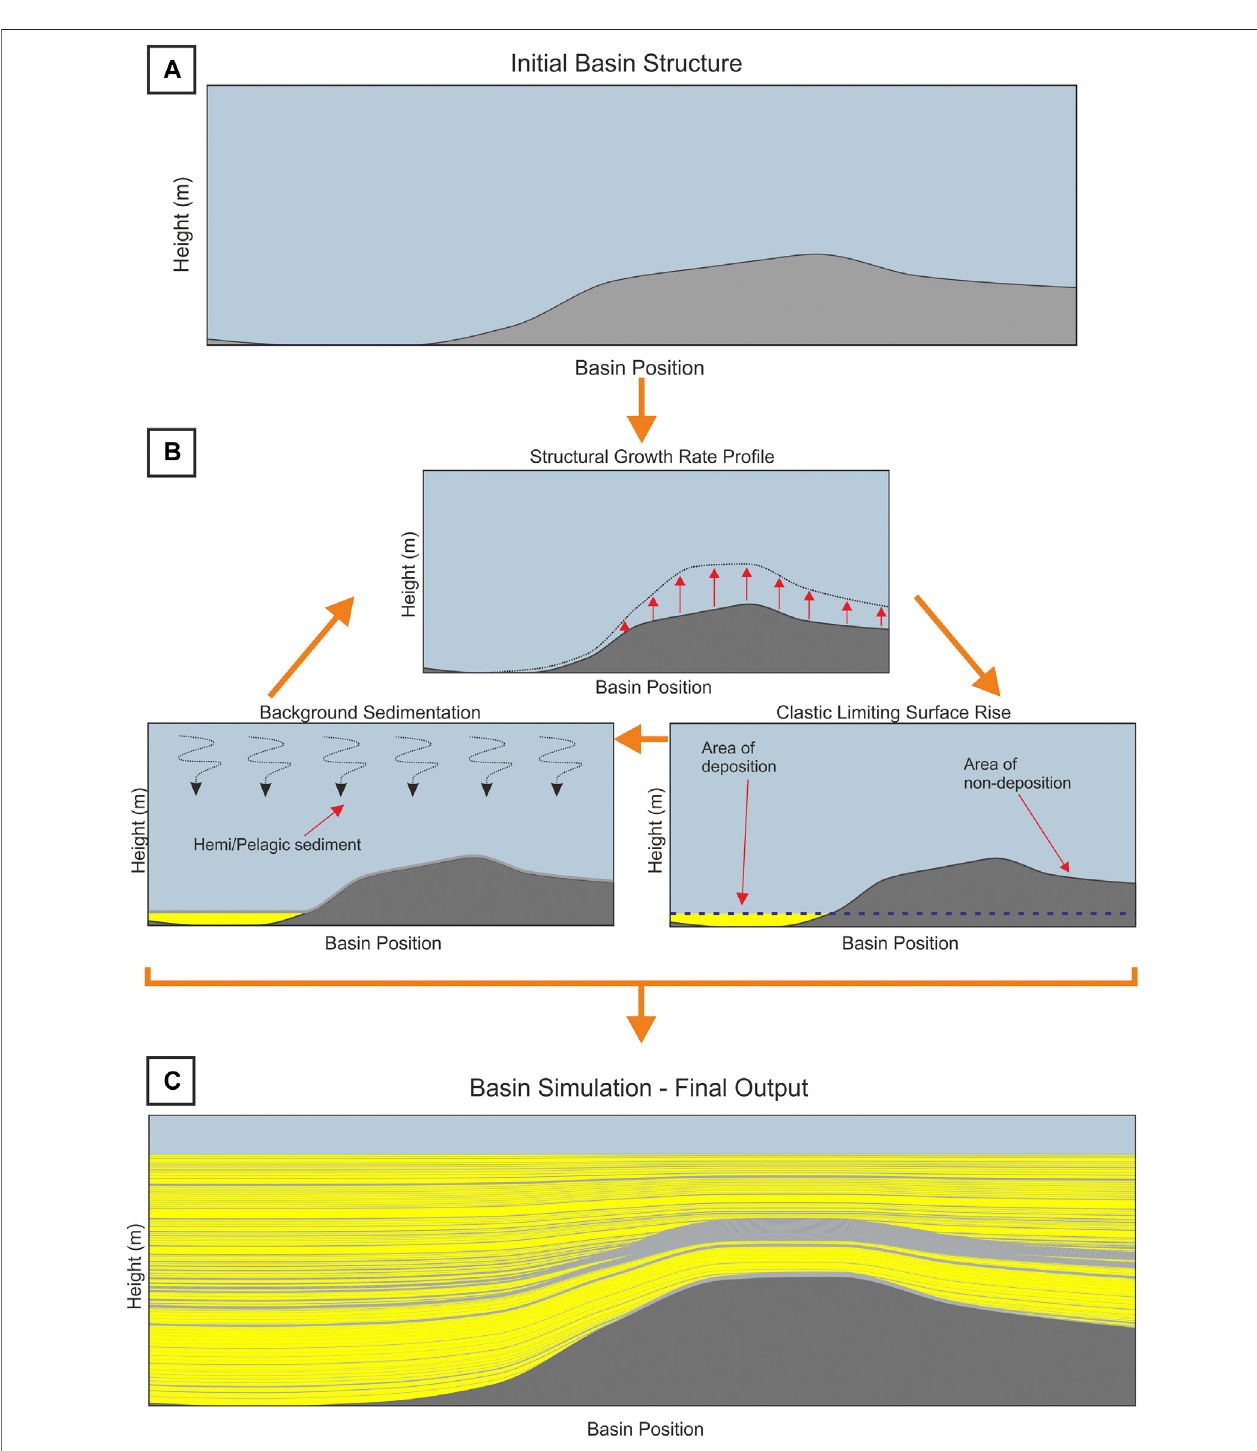
FIGURE 4 | (A) : Time Step 0 shows the Initial Basin Structure with height in meters on the Y axis and Basin Position on the X axis. (B) : Onlapse – 2D applies a structural growth rate to the initial basin structure, then Onlapse – 2D applies a rise to the clastic limiting surface and if there is accommodation available gravity fl ow deposit packages are preserved. After this, Onlapse – 2D applies a uniform thickness of pelagic/hemipelagic sediment across the cross section. Section B is repeated a number of times as dictated by the number of Time-Steps. Producing a fi nal cross section, (C) .